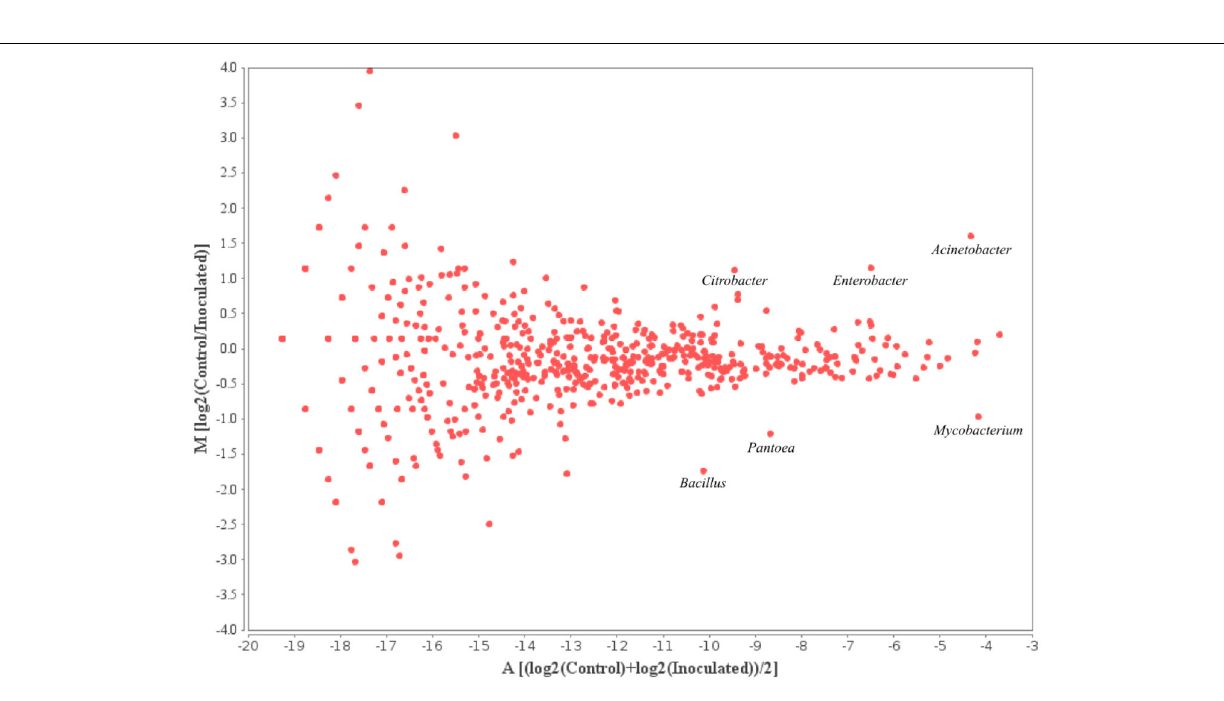
around 6.1% within the samples taken after 2 days to 5.5% for the samples taken after 2 and 5